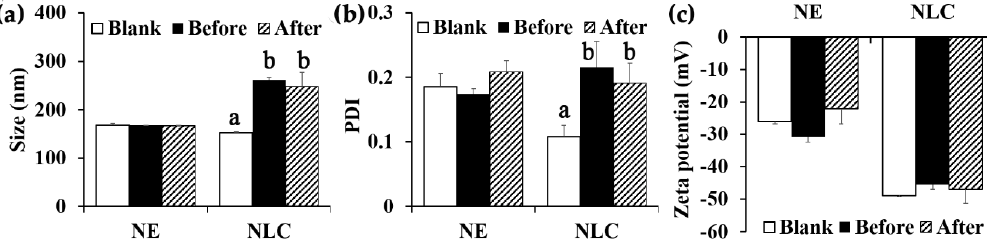
Figure 6. ( a ) Internal droplet size, ( b ) PDI, and ( c ) zeta potential of nanoemulsion (NE) and nanostructured lipid carrier (NLC) without O. sanctum ethanolic extract ( ) and with O. sanctum ethanolic extract before ( ) and after ( ) 8 cycles of heating–cooling stability test. The letters a and b denote values that were significantly different ( p < 0.05).